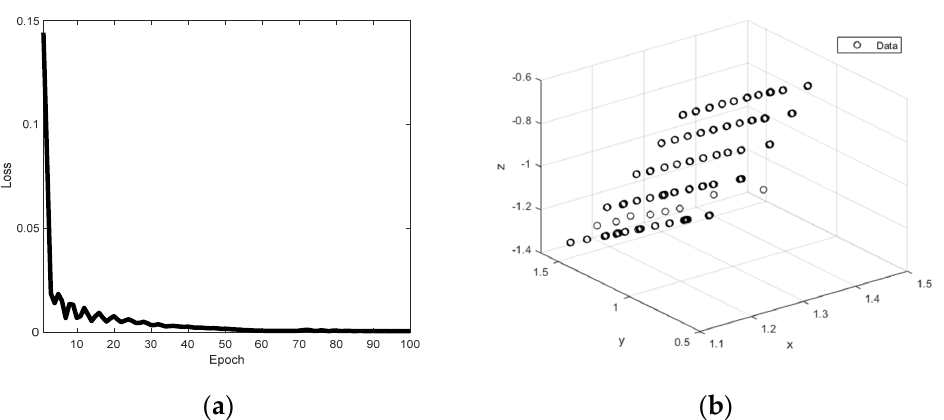
Figure 5. Results of model training: ( a ) model loss and ( b ) the three-dimensional vectors of training dataset.